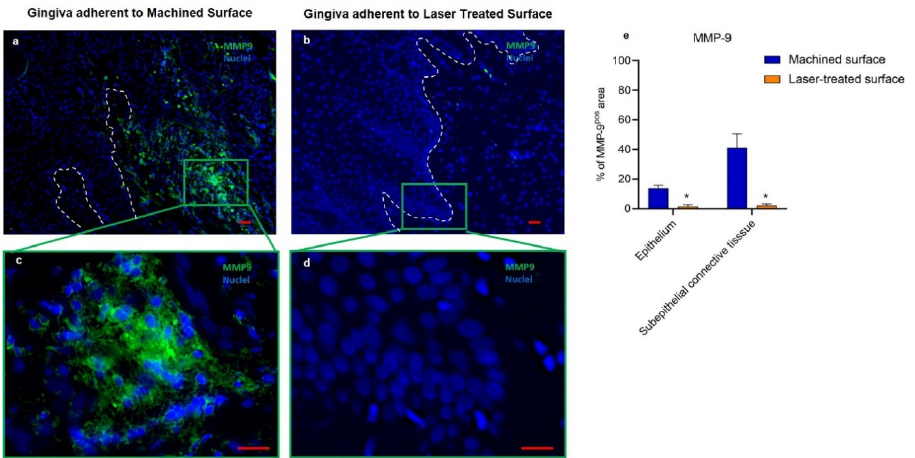
Figure 3. Immunofluorescence against MMP-9 (green) of the region of the gingiva adherent to the machined ( a , c ) or laser-treated ( b , d ) surfaces. The white dotted line indicates the basal lamina area that is regular in ( b ) and disrupted in ( a ). Nuclei are counterstained with DAPI. Scale bar: 10 µ m. Images are representative of 15 di ff erent experiments ( e ) Percentage of ICAM-1 immunostaining positive area in the epithelial layers and the subepithelial connective tissue. Values represent the % of positive area, calculated as the mean of five di ff erent determinations in randomly chosen sections for each specimen. Values are expressed as mean ± SD * indicates values statistically di ff erent ( p < 0.001) between the region of the gingiva adherent to the laser-treated- or to machined surfaces, as